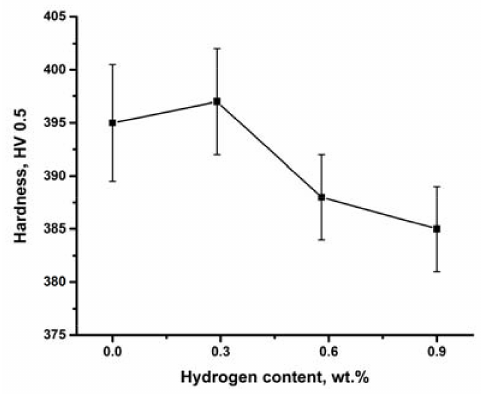
Figure 10. Hardness of EBM titanium Ti-6Al-4V parts as the function of hydrogen